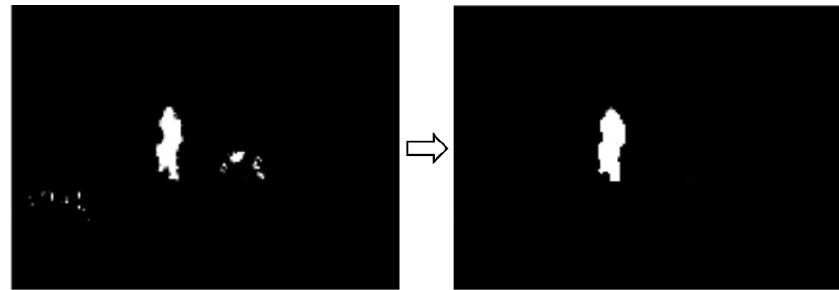
Figure 17. Image detection — postprocessing.